Question: Summarize what this figure shows in one sentence.
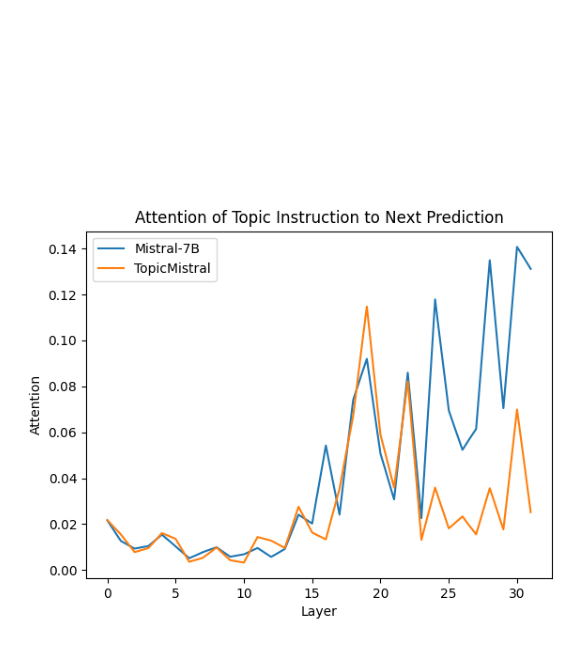
Answer: Average attention weight shift on Mistral-7B and TopicMistral. The x-axis represents the number of hidden layers and y-axis indicates the average attention weight from topic instruction to the next prediction to- ken.